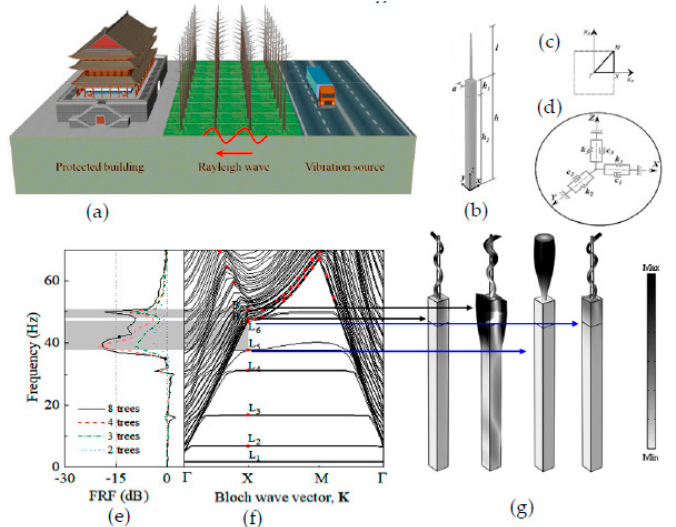
Figure 8. Urban forest as large-scale NMs: ( a ) Rayleigh waves and periodic arrangement of forest trees; ( b ) unit cell; ( c ) wave vector in first IBZ; ( d ) viscous spring boundary, ( e ) FRF plot, ( f ) dispersion curves with FBGs, and ( g ) vibration modes corresponding with FBGs boundaries. Figure reproduced with permission from [128].